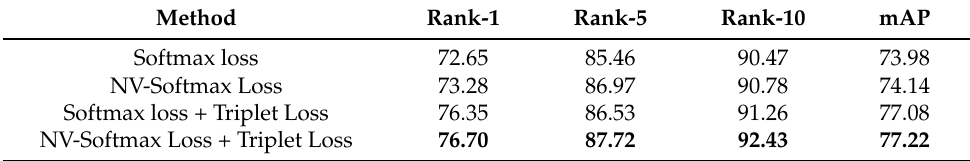
Table 1. Ablation experiments on